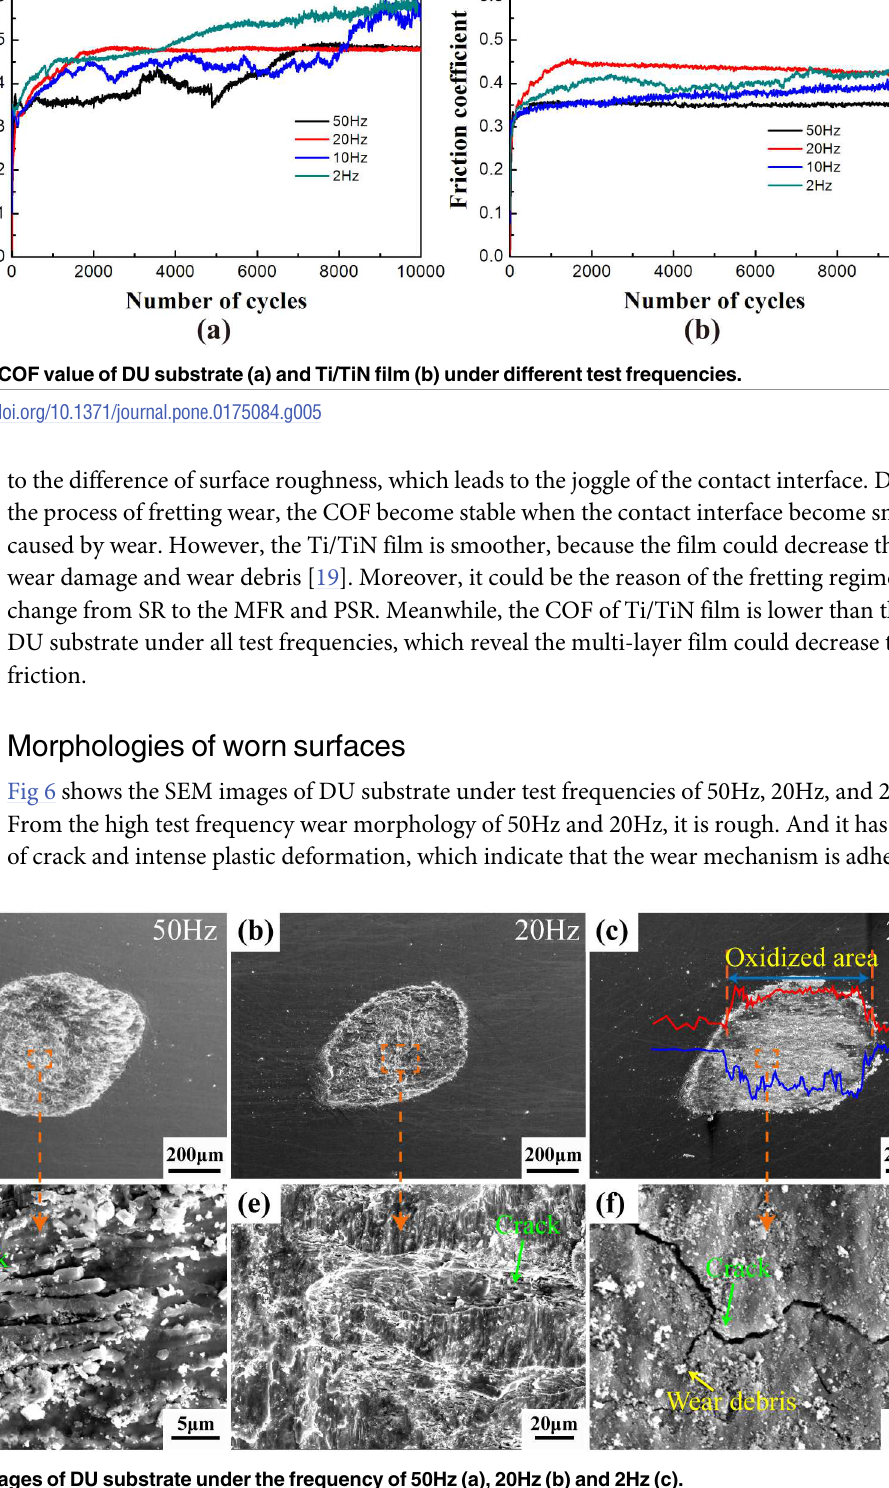
Fig 6. SEM images of DU substrate under the frequency of 50Hz (a), 20Hz (b) and 2Hz